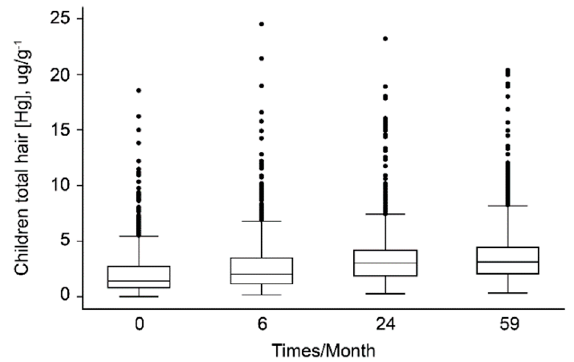
Figure 2. Hg levels in the hair samples of children over time (Friedman’s χ 2 = 2270.3; p < 0.0001).